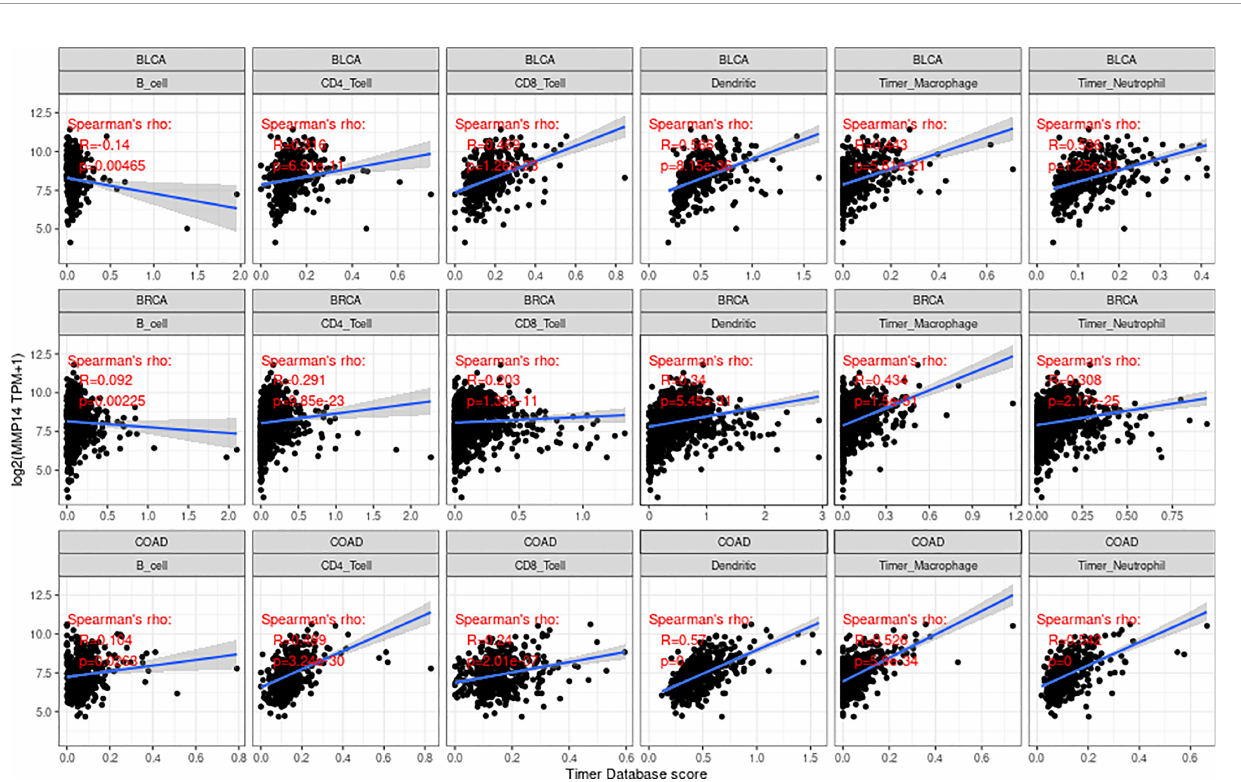
FIGURE 6 | The expression of matrix metalloproteinase 14 (MMP14) in bladder urothelial carcinoma (BLCA), breast invasive carcinoma (BRCA), and colon adenocarcinoma (COAD) was correlated with the level of immune in fi ltration (B cells, CD4 T cells, CD8 T cells, macrophages, dendritic cells, and neutrophils). Only in BLCA was the expression of MMP14 negatively correlated with B-cell in fi ltration, and the others were positively correlated with the six kinds of immune cell in fi